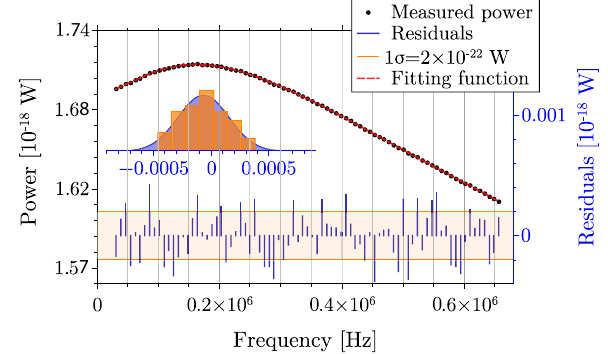
Fig. 6 Down-converted power spectrum and residuals of RUN31. The black dots are the measured data points and their error is within the symbol dimensions, the red line is a polynomial fit of such points. The residuals are represented in blue and, as an inset, we show them on an histogram. The corrupted intervals are removed